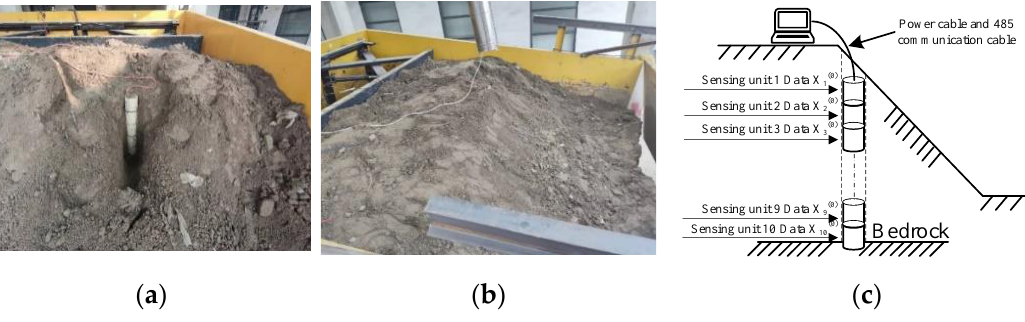
Figure 10. Initial state diagram of experiment. ( a ) Description of the initial state of the entire deep displacement monitor sensor on the slope. ( b ) Show a 1 m high slope with a 20 cm high plane to simulate the toe of the slope ( c ) A sectional view of the distribution of the integrated deep displacement three-dimensional measuring sensor buried in the slope.